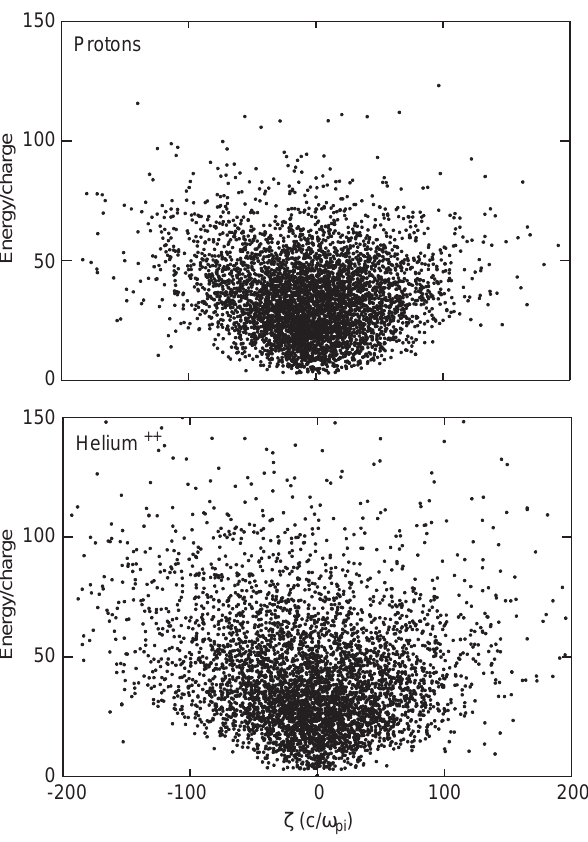
Fig. 10. Energy per charge in units of the shock ram velocity E p of upstream ions versus time s spent at shock. a protons; b